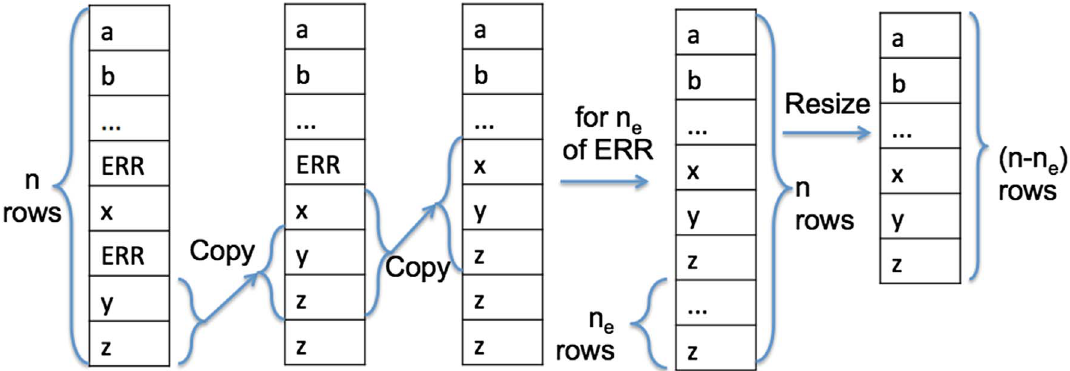
Fig. 6. Algorithm for removing error values in the binary table extension. The number, n e , of error values are randomly distributed in the data array, which has millions of rows. In the fi rst step of processing, a row with an error value ERR is overwritten with the following normal values y – z . After overwriting all error values, the data array is resized only once, and n e rows are removed from the end of